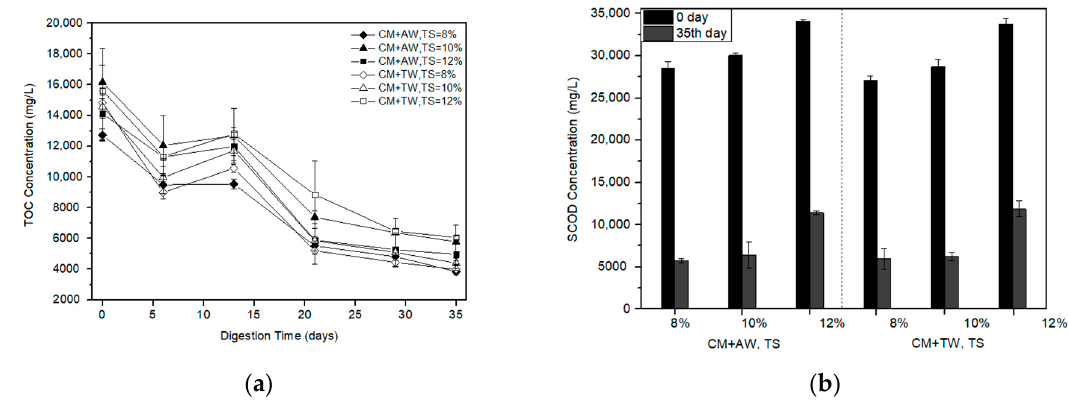
Figure 3. TOC concentration ( a ) and SCOD removal ( b ) profile with the digestion time for diluted CM.